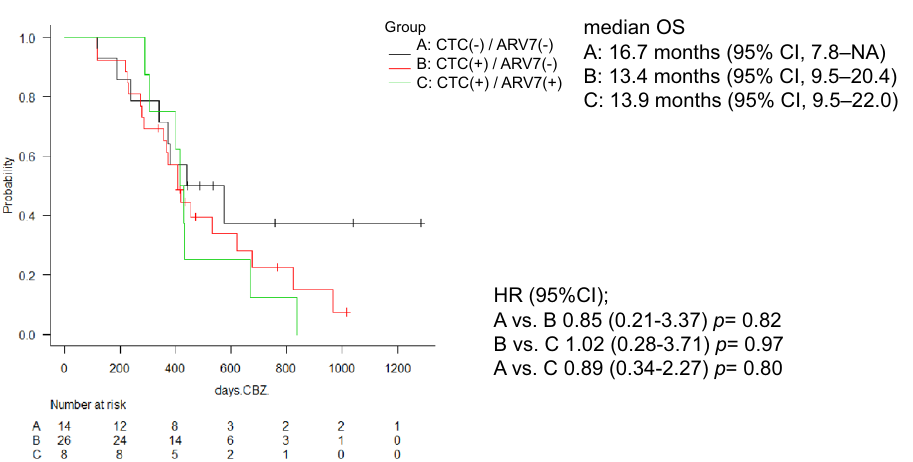
Figure 3. Kaplan–Meier curve of overall survival (OS) rate of groups with or without CTC and AR-V7 status at baseline. Group A, CTC (−) / AR-V7 (−); Group B, CTC ( +) / AR-V7 (−); Group C, CTC ( +) / AR-V7 ( +), analyzed by log-rank test (N = 48). Median OS was 13.9 months (95% CI, 9.5–22.0) in the group C, 13.4 months (95% CI, 9.5–20.4) in the group B, and 16.7 months (95% CI, 7.8–NA) in the group A. HR (95% CI): A vs. B, 0.85 (0.21–3.37), p = 0.82; B vs. C, 1.02 (0.28–3.71), p = 0.97; A vs. C, 0.89 (0.34–2.27) p = 0.80. AR-V7, androgen splicing variant-7; CI, confidence interval; HR, hazard ratio; CTC, circulating tumor cell; OS, overall survival; (−), negative; ( +),